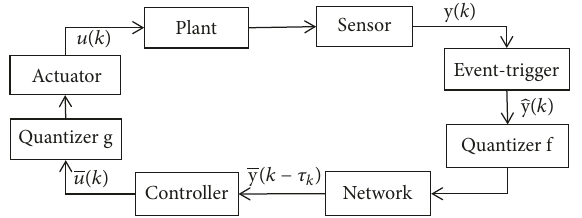
Figure 1: The structure of NCS with event-trigger and